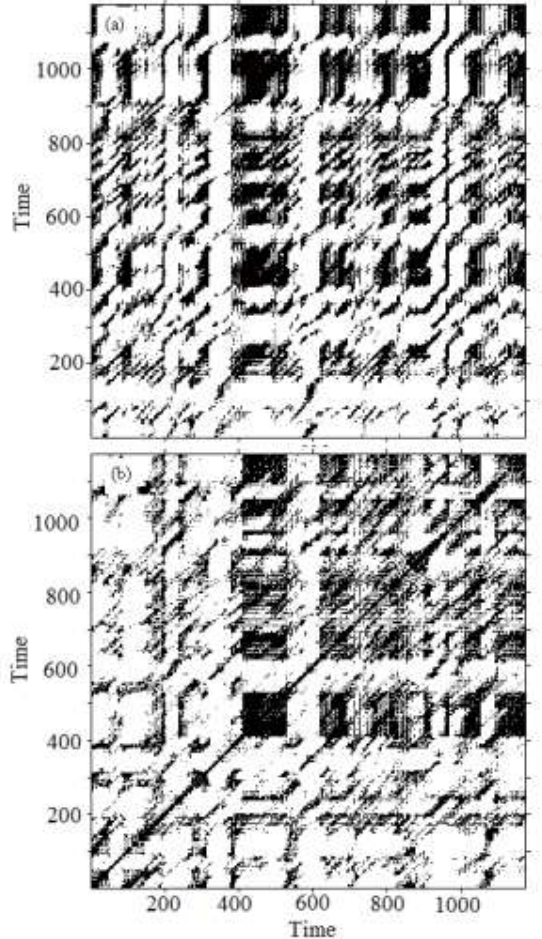
Figure 15. (a) CRP and (b) JRP of wind speed and wind power time series'.